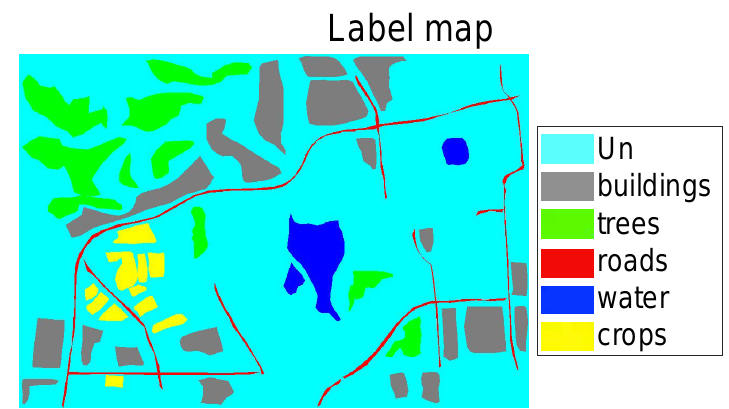
Figure 3. Labeled map for training data generation.